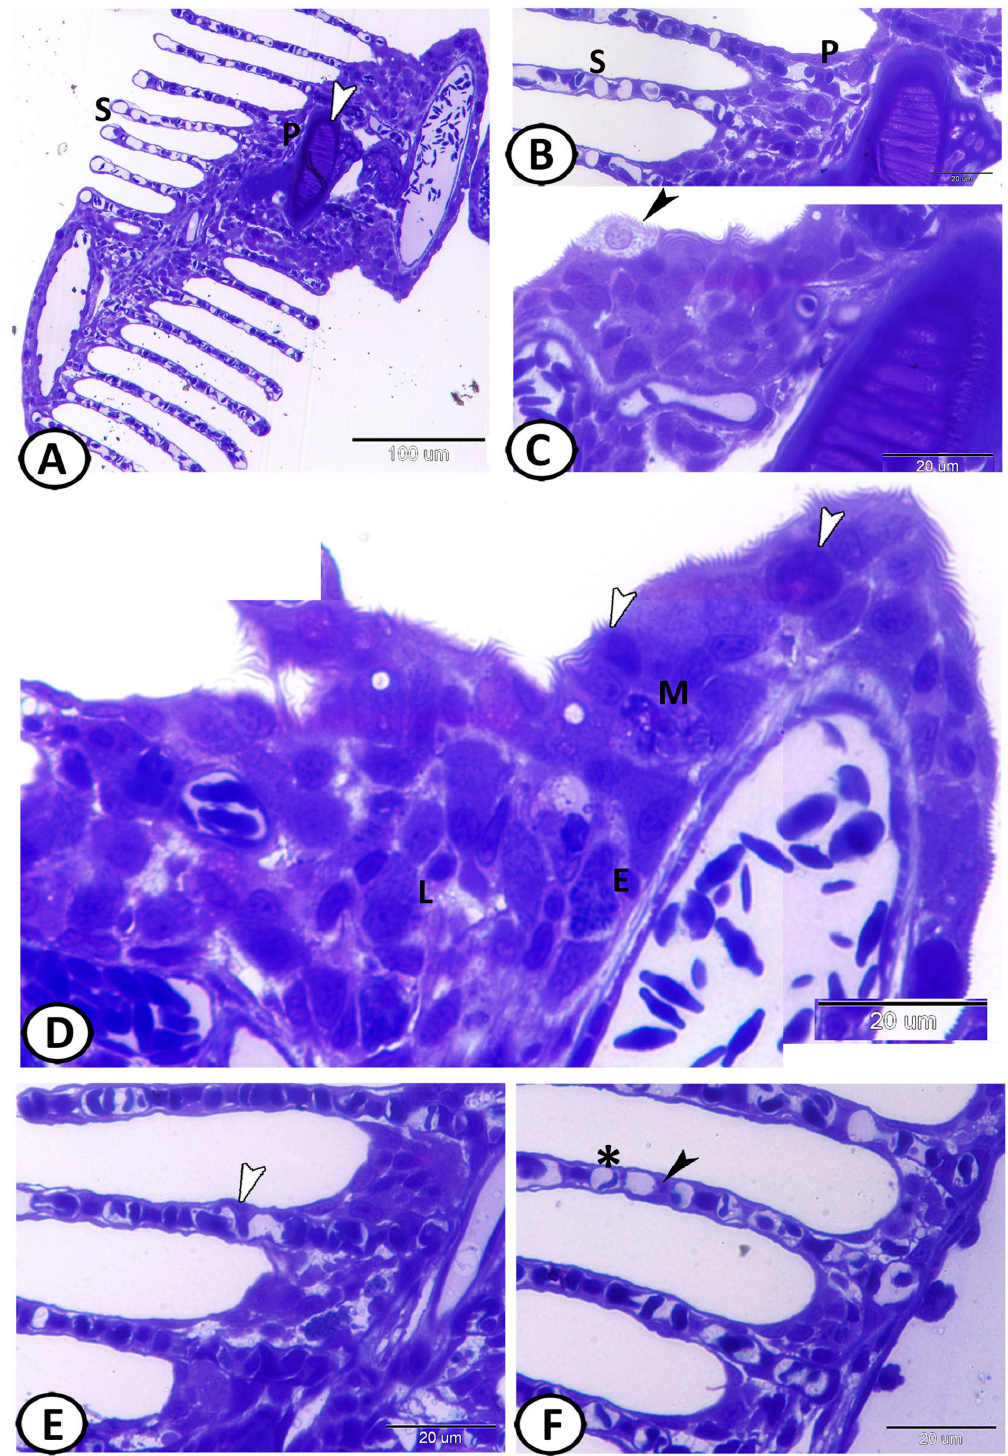
Figure 3. Semithin sections stained with toluidine blue. ( A , B ) the gill filaments consist of primary (P) and secondary (S) gill lamellae. ( C , D ) Higher magnification of one primary gill lamella shows its covering stratified epithelium with chloride cells (black arrowhead), mucous cells (white arrowheads), macrophages (M), and lymphocytes (L). Note the presence of endocrine cells (E) with metachromatic granules in the vicinity of the blood vessels. ( E , F ) The secondary lamellae consisted of pillar cells (black arrowhead) separated by blood capillaries (asterisk). The surface of the secondary lamellae is covered by pavement cells (PVC, white arrowhead).